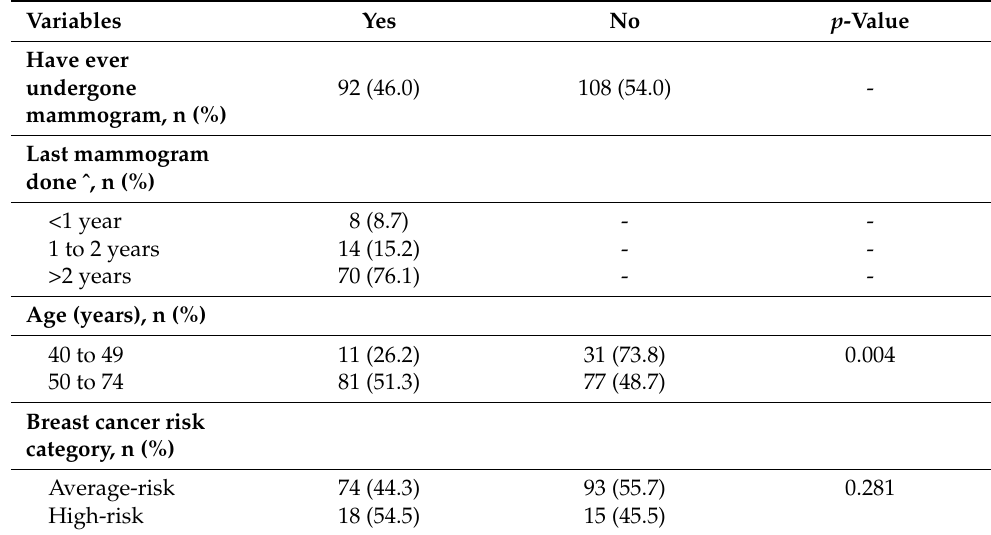
Table 2. Prevalence of screening mammogram uptake according to age and breast cancer risk